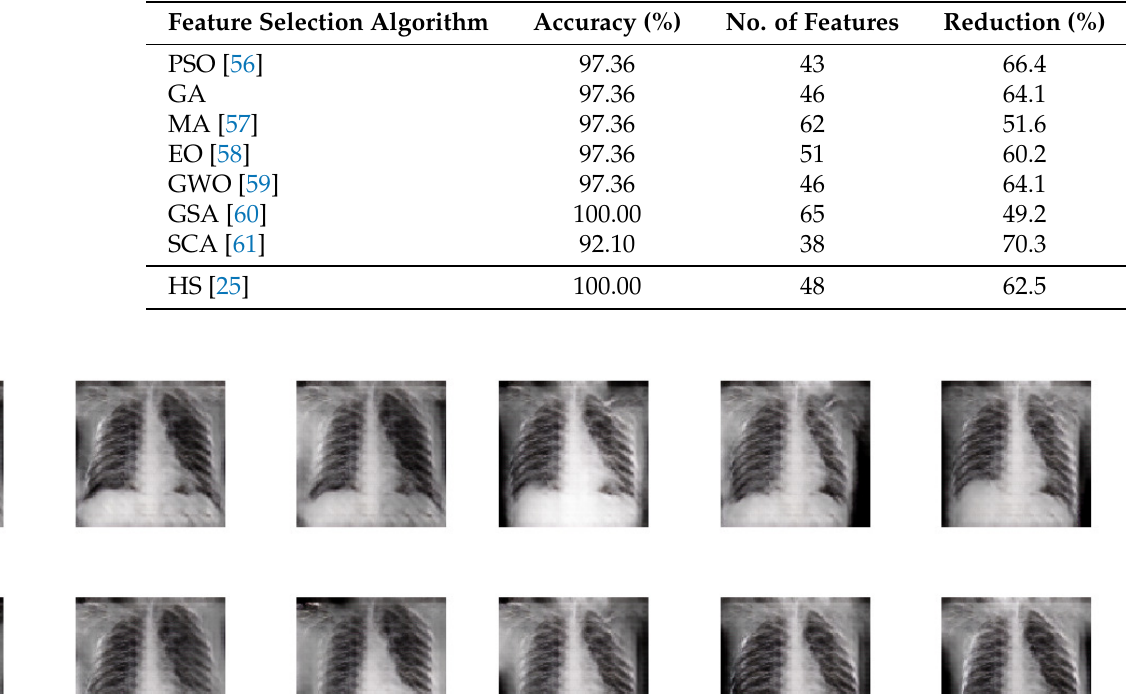
Table 3. A comparison of the performances of various state-of-the-art feature selection algorithms on the mixed dataset (50% original data and 50% synthetic data). The VGG16 features of initial dimension 128 were used.